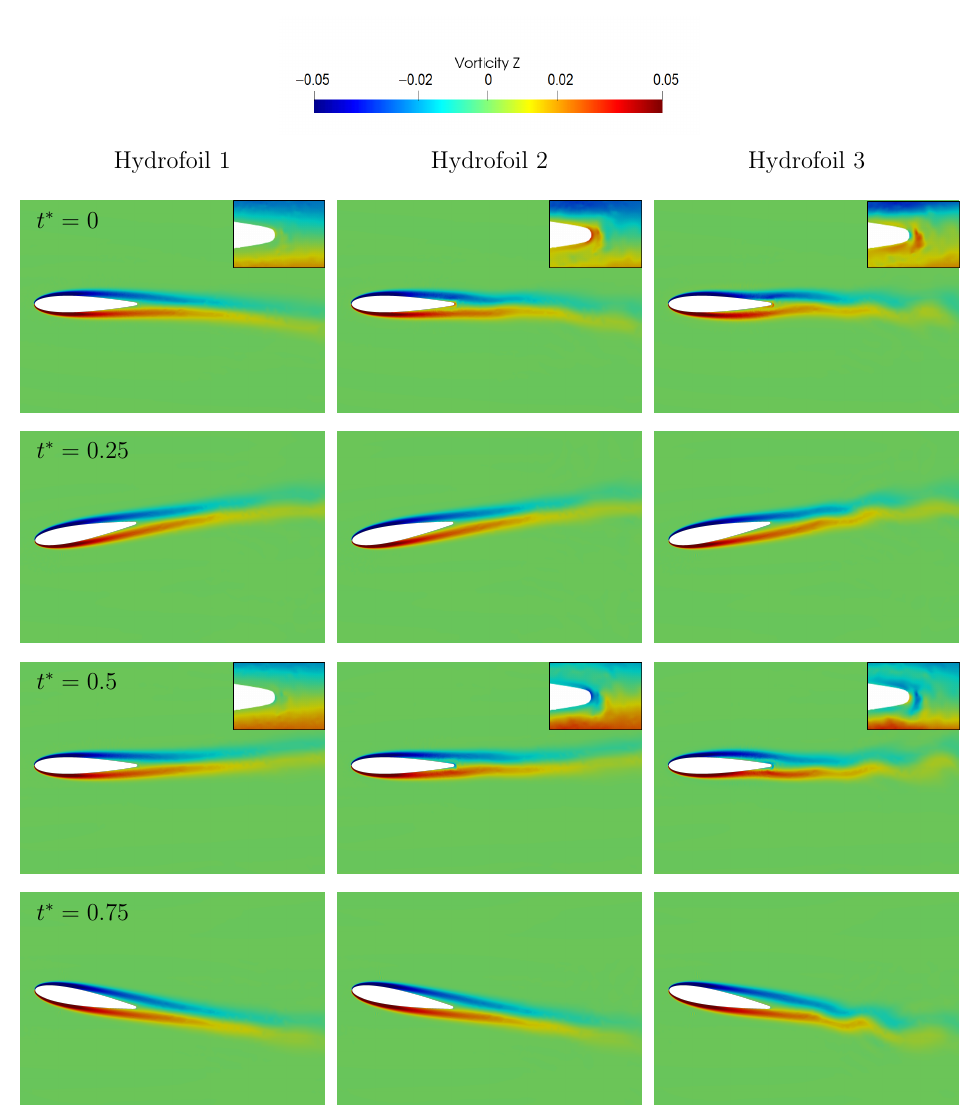
Figure 5. Instantaneous vorticity fields ω z around the oscillating hydrofoil for the hydrofoils 1, 2, and 3, α 0 = 10 ◦ , f ∗ = 0.025, ∆ h = 0.8 m, and t ∗ = 0, 0.25, 0.5,